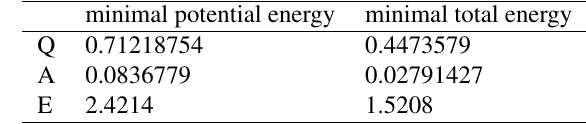
Table 1. Calculated values for charge and minimal